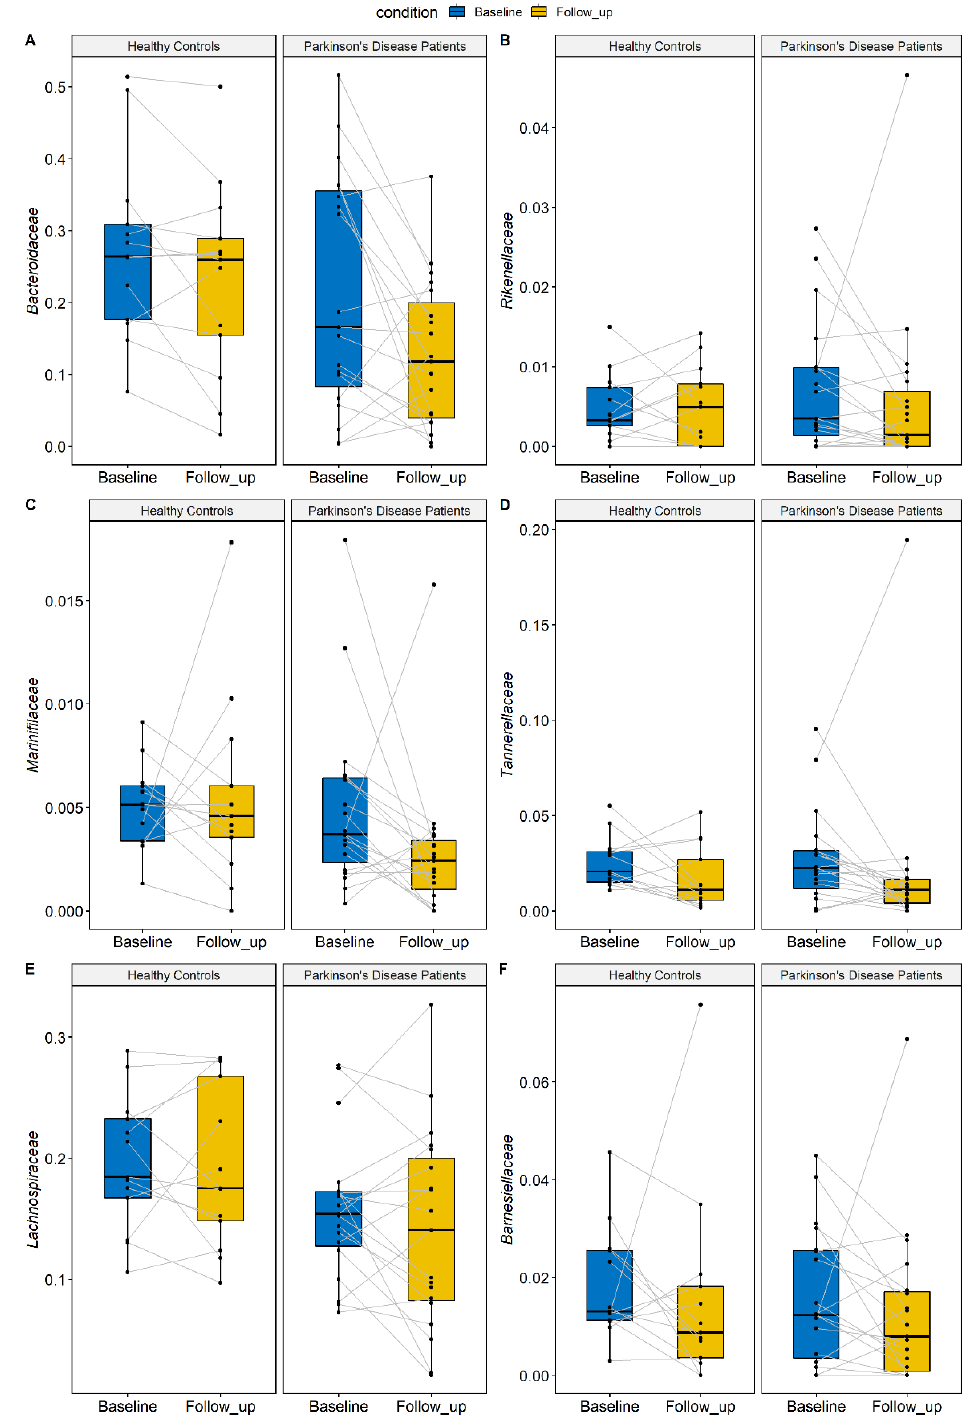
Figure 3. Taxa identified by the repeated-measure ANOVA test. All the families are reduced in both patients and controls at the follow-up (colored in yellow) compared to the baseline (colored in blue), independent of the health status (PD or HC). The effect of time is statistically significant after performing a multiple test correction. Table 2. Bacterial families identified by the repeated-measure ANOVA test. The relative abundance is reported for HC and PD patients at baseline and follow-up tests. The p-values reported refer to the significance between HC and PD patients (status), follow-up and baseline (time), or considering the effect of status and time. All the p-values are corrected for multiple testing.